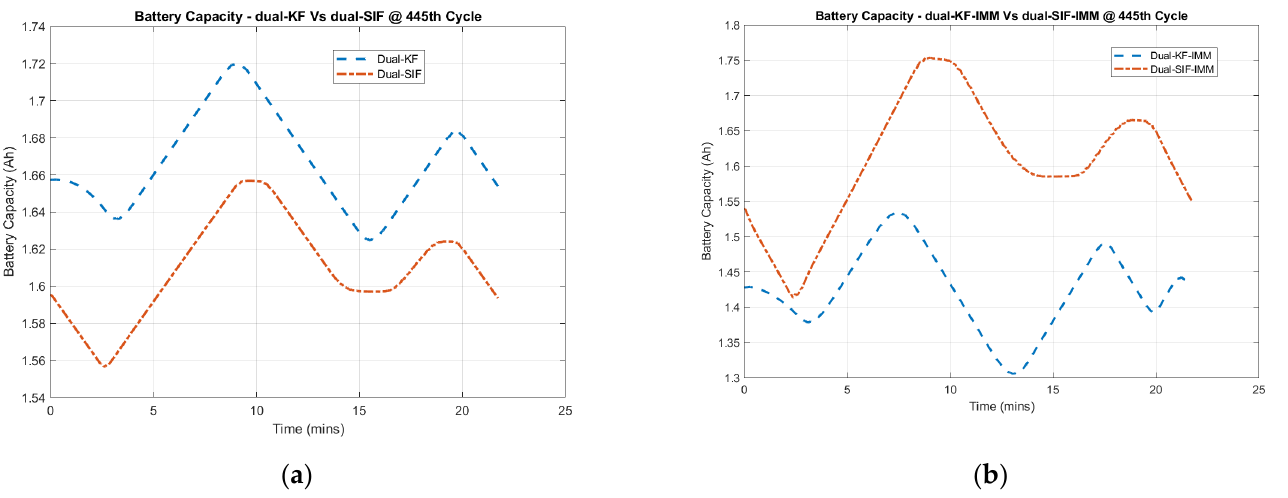
Figure 16. ( a ) Dual-KF and dual-SIF battery capacity estimates at cycle 445. ( b ) Dual-KF-IMM and dual-SIF-IMM battery capacity estimates at cycle 445.